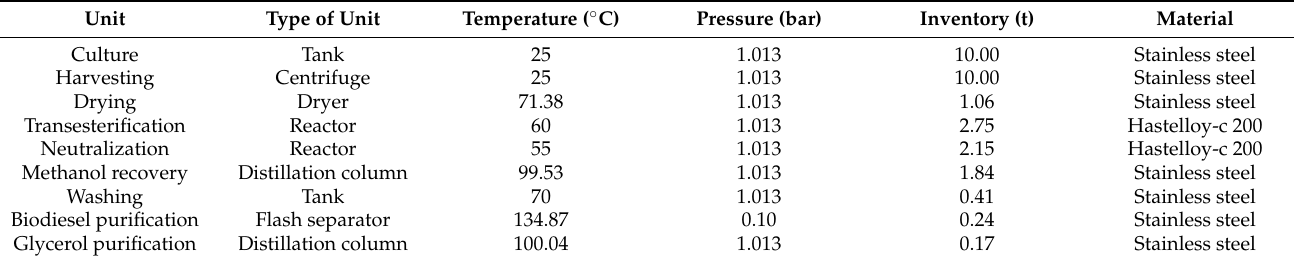
Table 5. Description of the main unit used for biodiesel production from microalgae via in